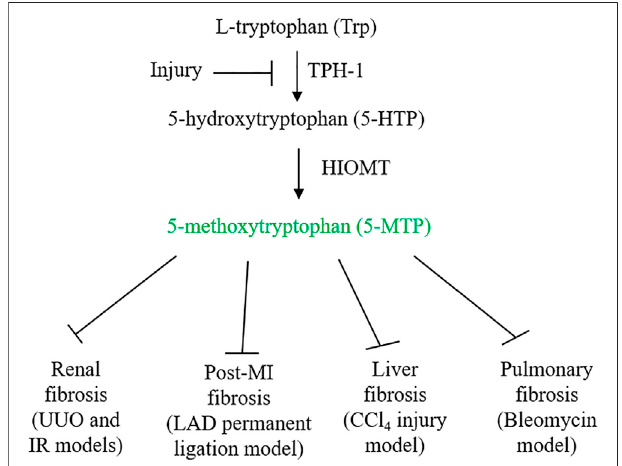
FIGURE 1 | 5-MTP synthetic pathway and its inhibition by injury. Ischemia and in fl ammatory mediators suppress 5-MTP production by downregulating TPH-1 expression. 5-MTP suppression contributes to tissue in fl ammation and fi brosis. Administration of 5-MTP was reported to control fi brosis in vital